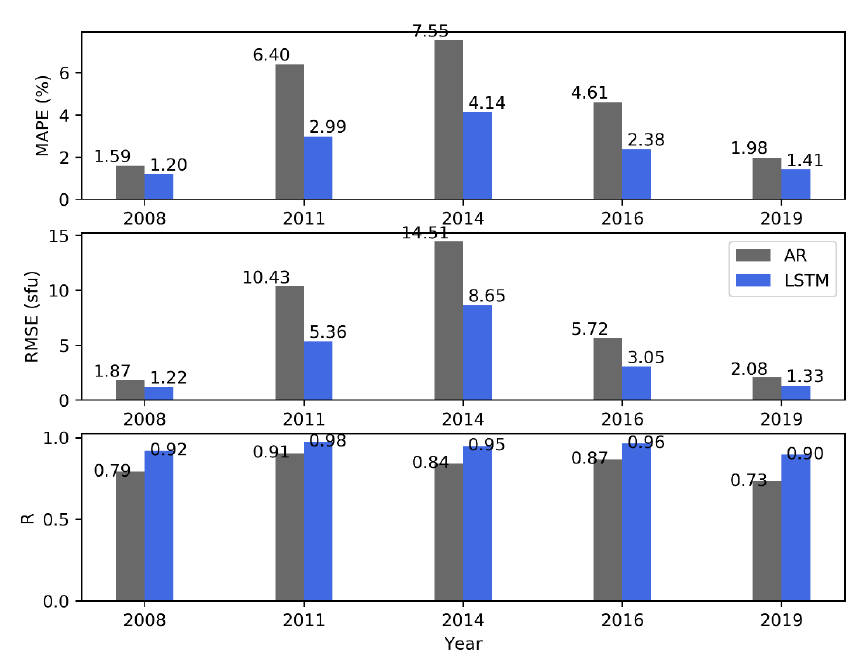
Figure 11. The same as Figure 9 but for 3-day prediction of models.